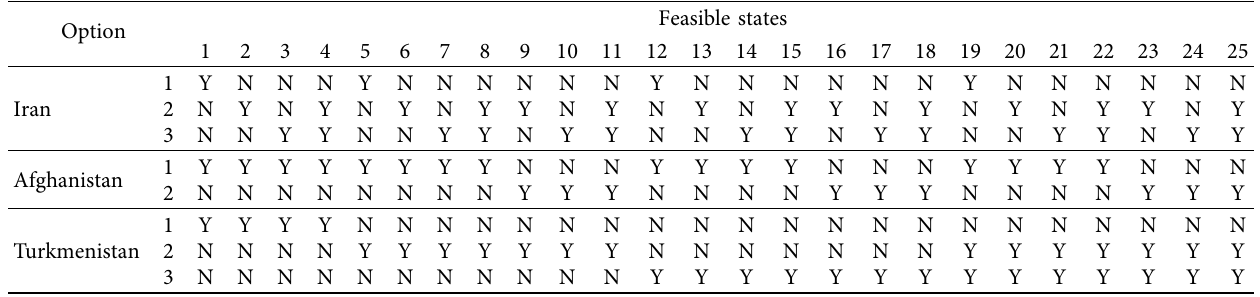
Table 3: Harirud river conflict feasible states.